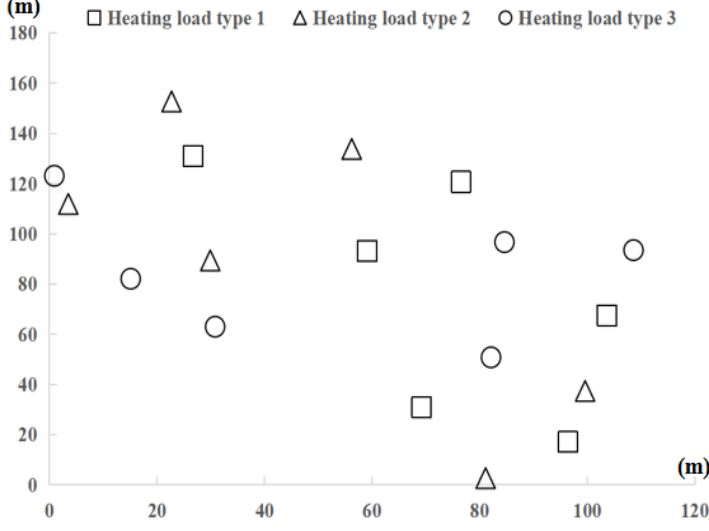
Figure 5. Distribution of buildings with different heating loads in the village.